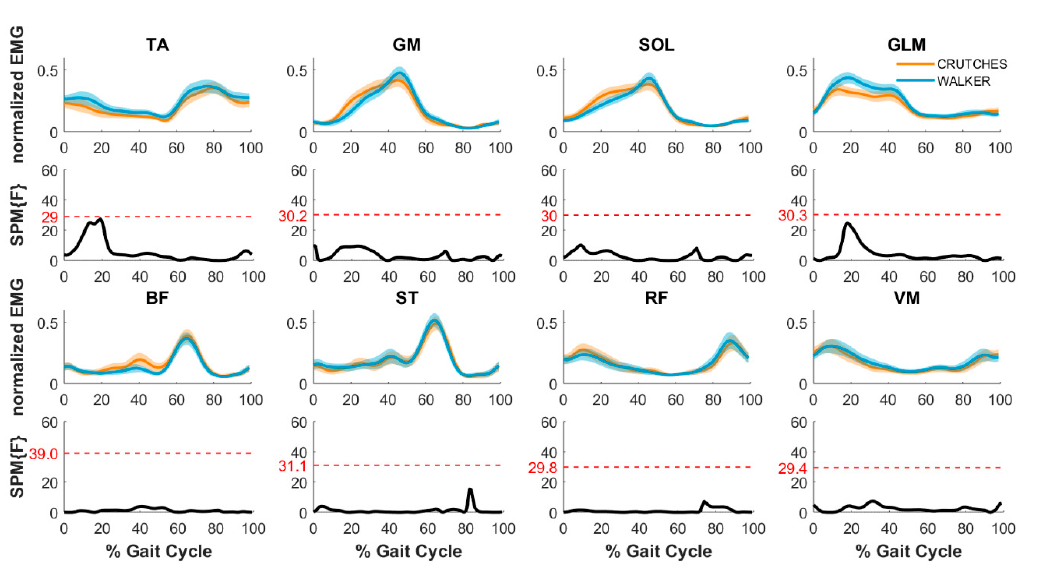
Figure 4. First and third rows: Muscle activation patterns (Mean ± SE) during walking inside the Ekso with the walker (blue lines) and crutches (orange lines). We considered the following muscles: tibialis anterior (TA), gastrocnemius medialis (GM), soleus (SOL), rectus femoris (RF), vastus medialis (VM), semitendinosus (ST), biceps femoris (BF), and gluteus medius (GLM). The lines were obtained by averaging all the modalities of walking with the Ekso (B-FA, B-AA, U-AA, B-NA, and U-NA) and the contribution of both legs that were balanced with respect the two aids. Second and fourth rows: Statistical parametric mapping (SPM{F}) statistic as a function of the percentage of gait cycle. The threshold for significance is indicated in red.